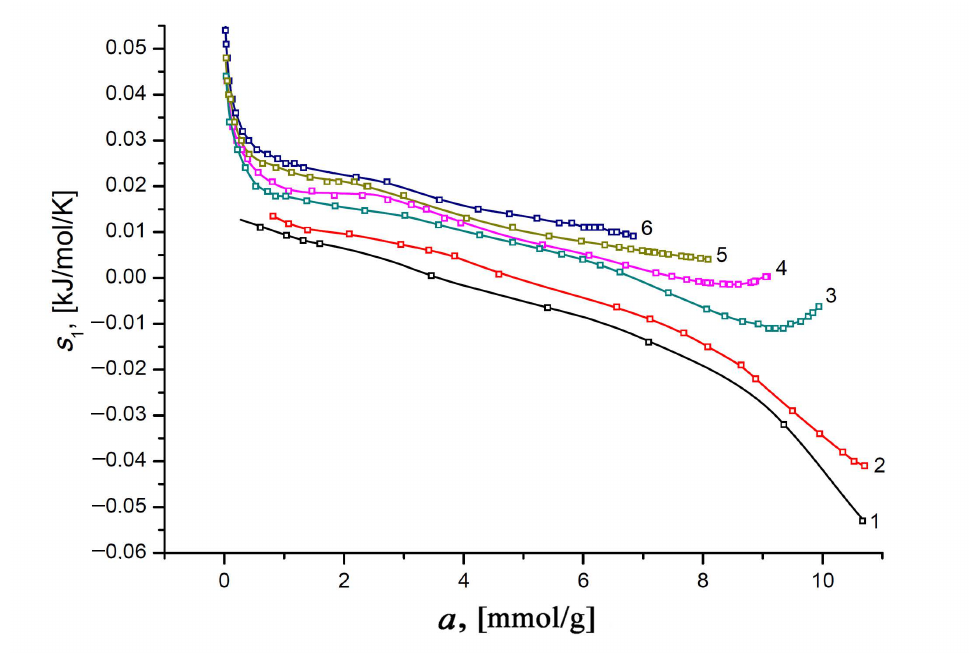
Figure 11. The differential molar entropy of the Xe/SiC-AC adsorption systems versus the values of absolute Xe adsorption at temperatures, K: 178 (1), 216 (2), 273 (3), 313 (4), 353 (5), and 393 (6). Symbols indicate the results of calculations by Equations (10) and (12); solid lines are the smoothing spline